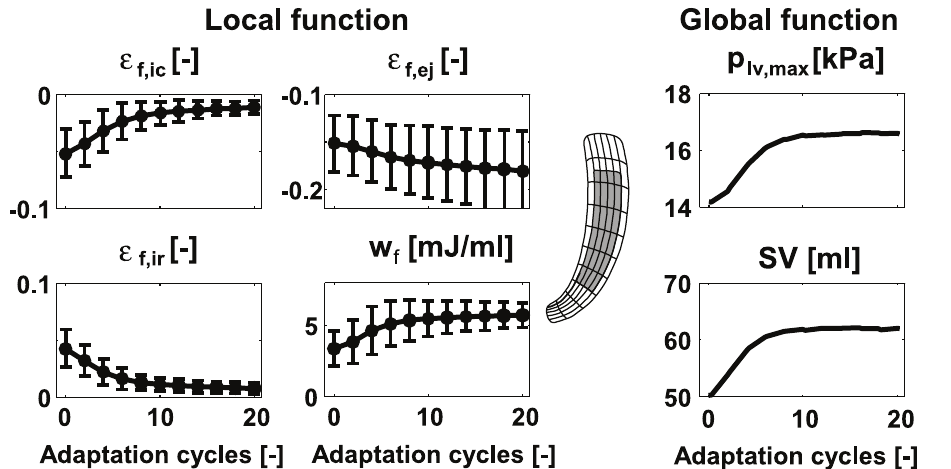
Figure 4. Evolution of local (left) and global (right) LV function in SIT simulation MID during the reorientation process. Local function is presented by means and standard deviations (SD) of variables natural myofiber strain during isovolumic contraction e ic , during ejection e ej , during isovolumic relaxation e ir , and stroke work density w f . The values were calculated from the grey area indicated in the long-axis cross-section of the LV mesh (mid). Global function is presented by maximum LV pressure p lv , max and stroke volume SV .